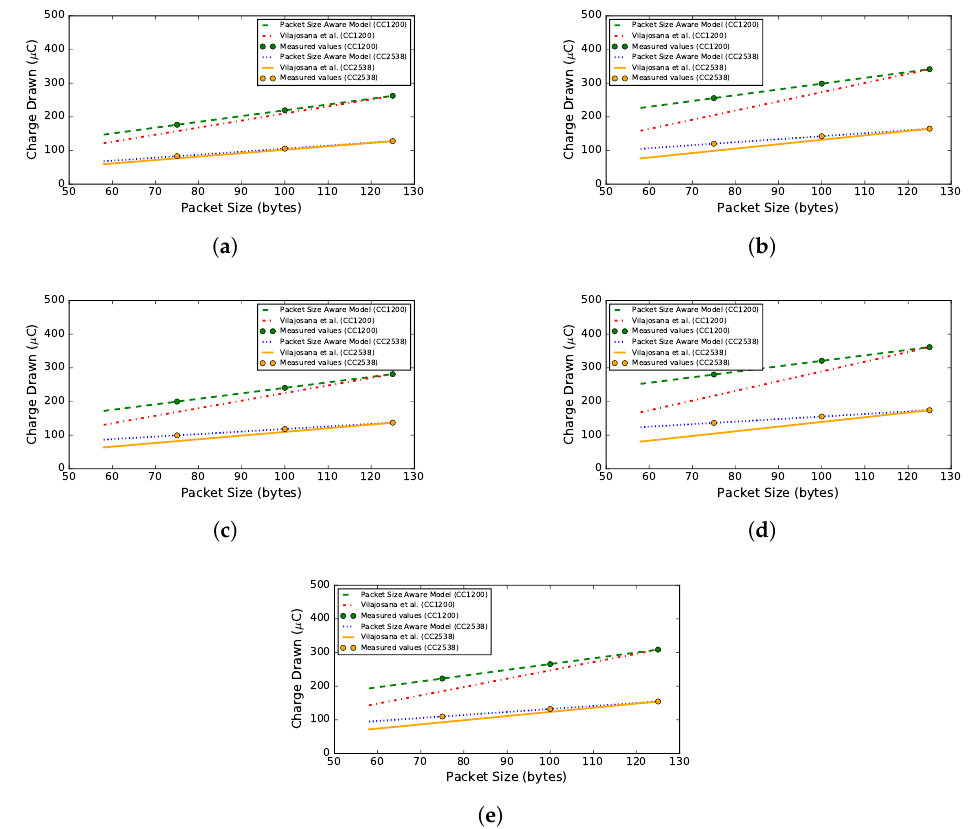
Figure 9. Comparison between the proposed packet size aware model and the model introduced by Vilajosana et al., which linearly scales the charge consumption based on the packet size. ( a ) TxData time slot; ( b ) TxDataRxAck time slot; ( c ) RxData time slot; ( d ) RxDataTxAck time slot; ( e ) TxDataRxNoAck time